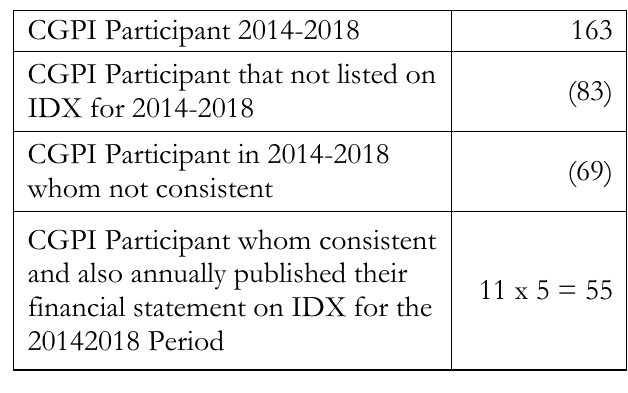
Table 1. Sampling Result